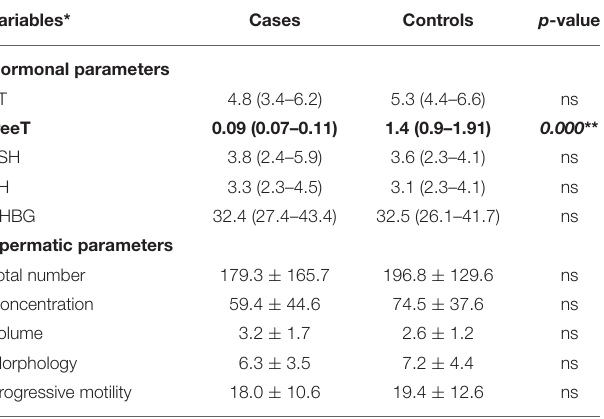
TABLE 1 | Demographic and clinical characteristics at enrolment. TABLE 2 | Hormonal assessment and spermatic parameters in RRMS patients at enrolment and in an age-BMI matched control population.